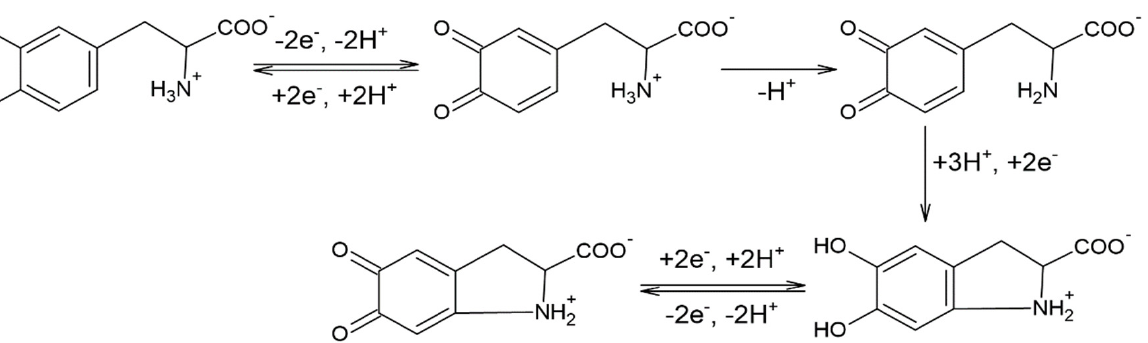
Figure 5. Cyclic voltammograms (three successive cycles) recorded by: ( a ) C-SPCE, ( b ) MC-SPCE and ( c ) OMC-SPCE im- mersed in 10 − 3 M L-DOPA solution for a 0.1 V·s − 1 scan rate.